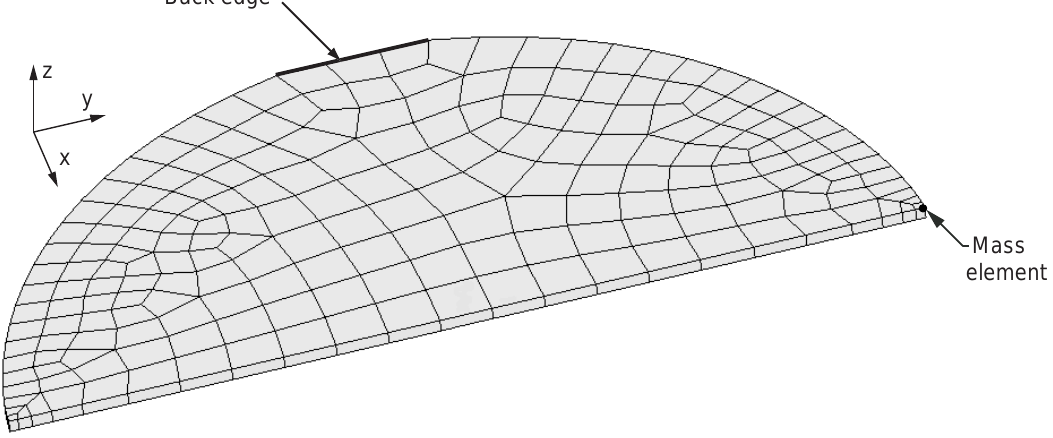
Figure 5. A typical mesh for a three-dimensional finite element model.